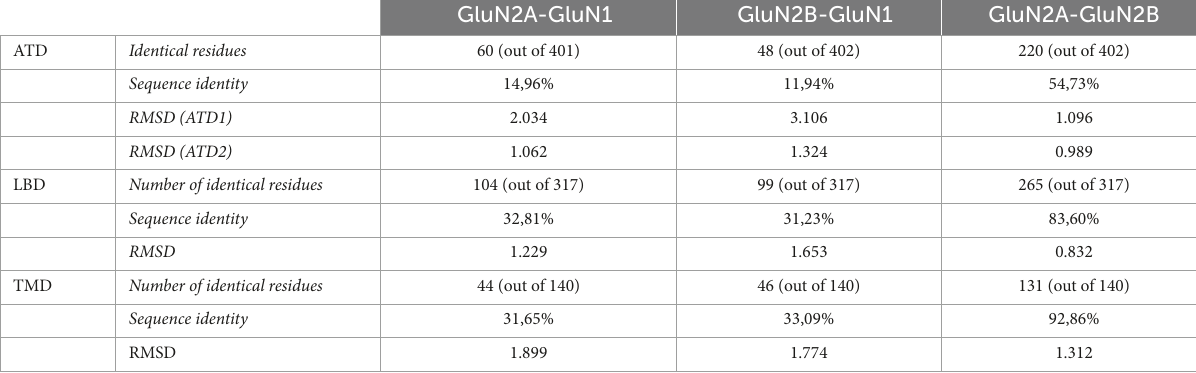
TABLE 1 Amino acid sequence identity and root mean standard deviation (RMSD) between GluN subunits, based on pairwise structural alignment of GluN subunit topological